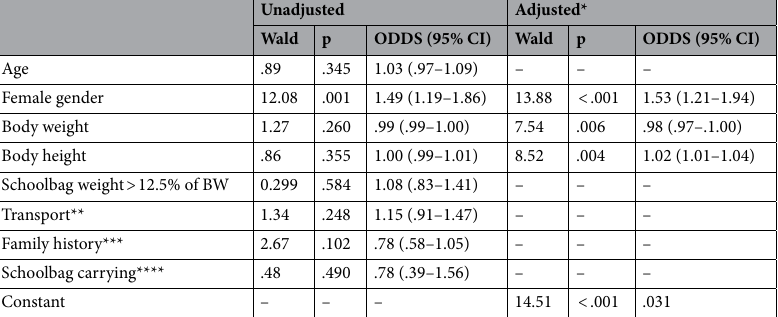
Table 3. Binary logistic regression model of the predicting wariables of abnormal angle of trunk rotation. BW, body weight. *Here are presented only variables that worked significantly in the model. **Transportation is a binomial variable consisting of: by walking and by vehicle. ***Family history is a dichotomous variable consisting of: positive history (when someone in the family has spine deviation) and negative history. ****Schoolbag carrying is a dichotomous variable consisting of carrying with one shoulder and carrying in the